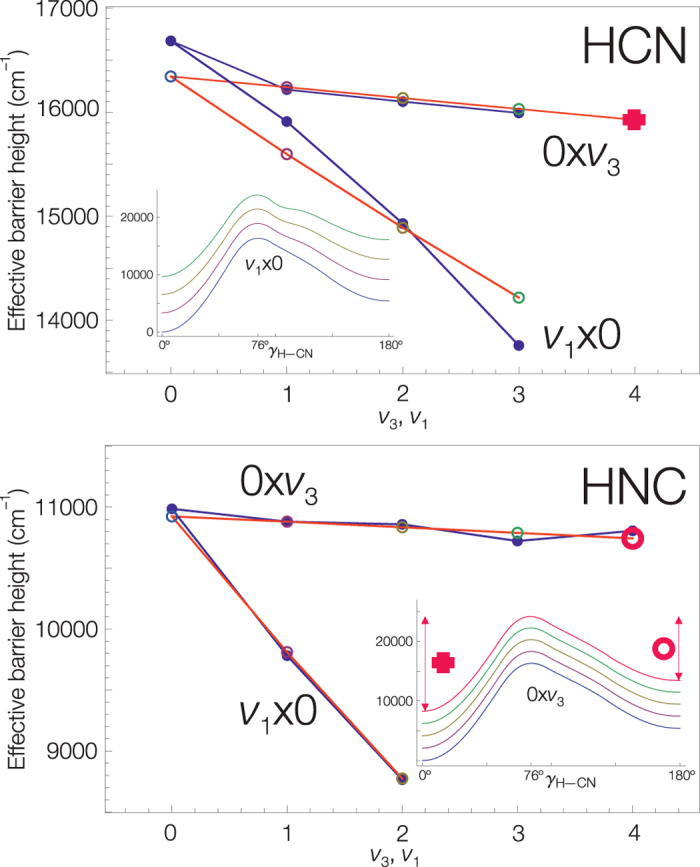
The H-C/H-N and C-N stretch excitation dependence on the (ν1, ν3, ℓ = 0) dynamic isomerization barrier heights for HCN and HNC.The data points joined with red lines correspond to the barrier heights of the  bending pseudopotentials calculated by Joyeux et al.19; the potentials for the (ν1, 0) and (0, ν3) are shown as inlets. The data points joined with blue lines are the barrier heights determined from the eigenenergy based quantum frequency correspondence analysis. The upper curve corresponds to C-N stretch spectator excitation; the barrier height is practically constant. The lower curve corresponds to H-C/H-N stretch excitation coupled with the bend isomerization mode. The two barrier heights agree within 1–2%, this agreement allows us to define pseudopotentials from pure spectroscopic experiments. The transition state can thus be considered a well defined pure quantum mechanical concept defined through molecular eigenstates.